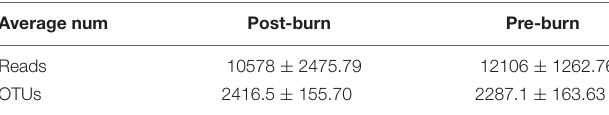
TABLE 2 | Operational taxonomic unit (OTU) numbers before and after the burn injury.